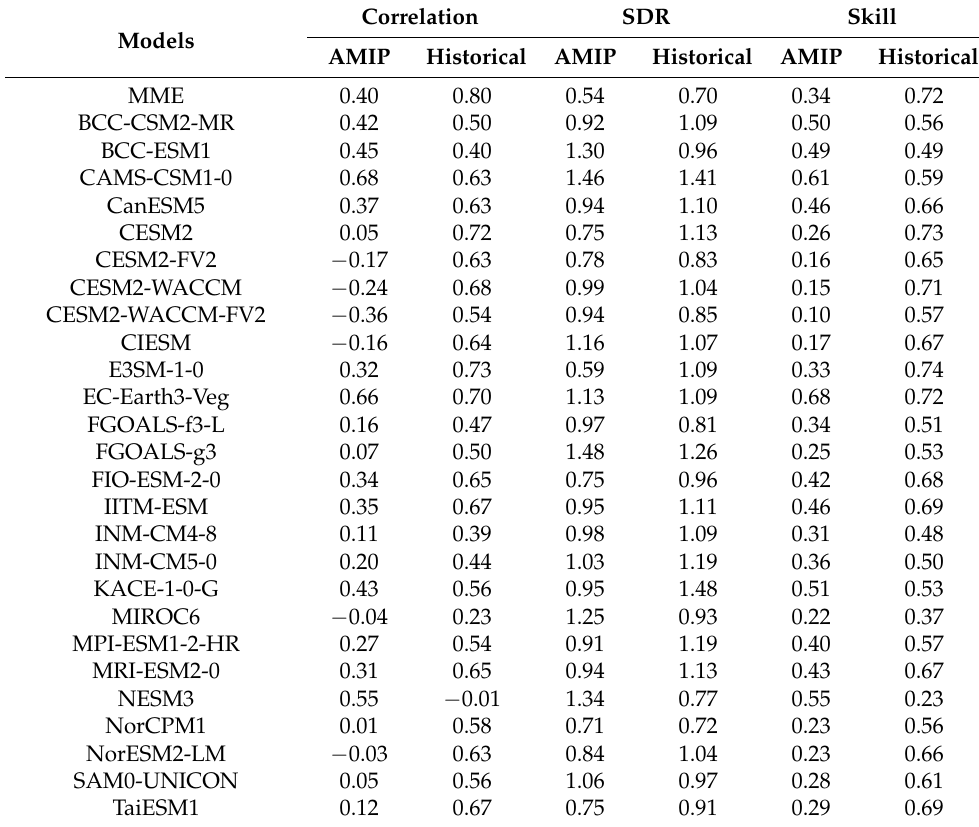
Table 3. Correlation coefficient, SDR and skills for precipitation.